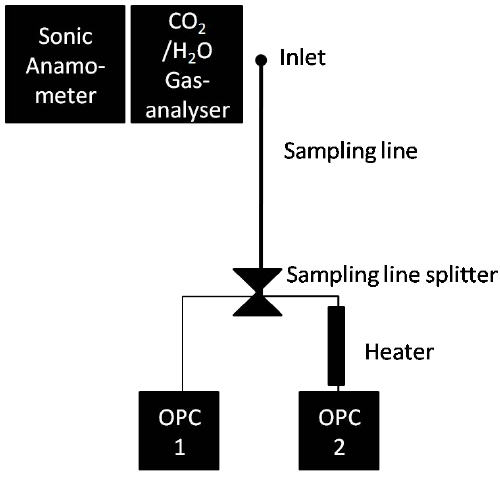
Fig. 2. Schematic of the measurement setup at Kalmgatan